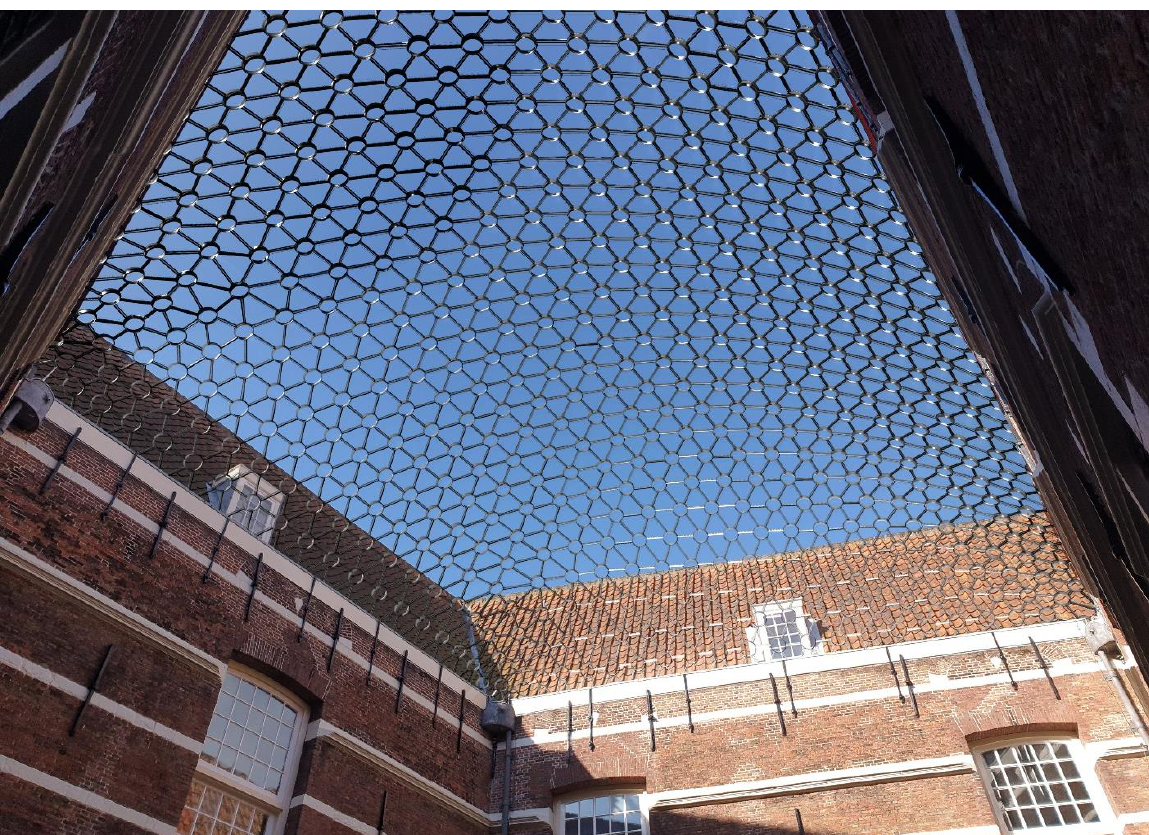
Fig. 13 Design for a cast glass shell structure covering the courtyard of the Armamentarium in